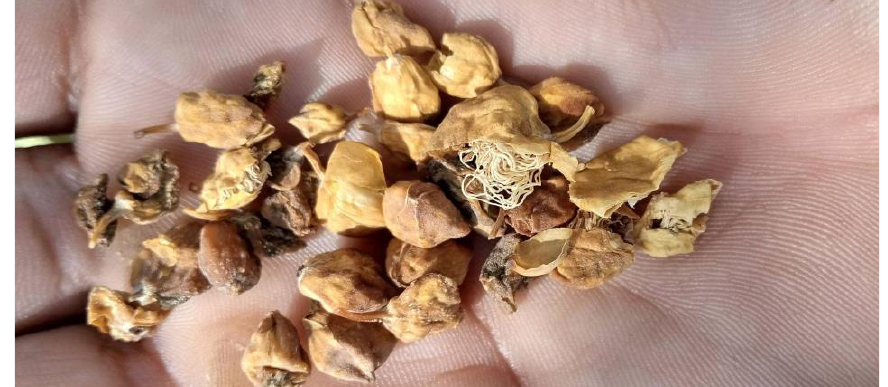
Figure 1. Dried flower buds of Capparis spinosa (Photo: Manduzai A.K.).